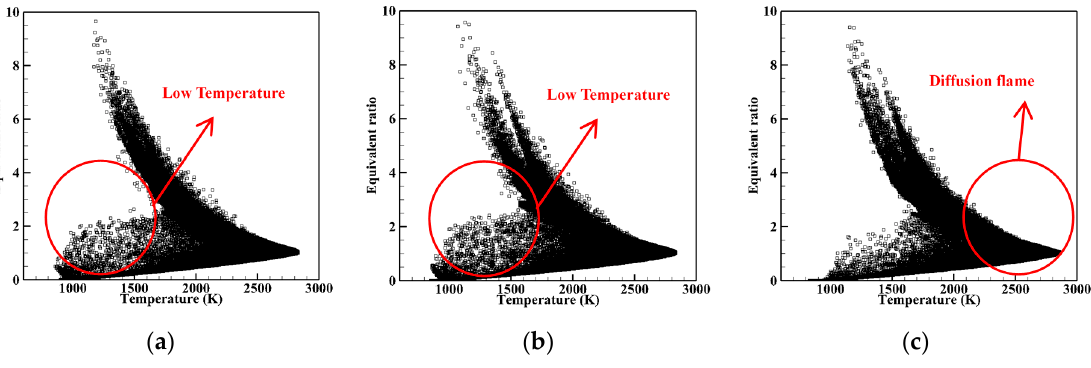
Figure 16. Map of equivalence ratio vs. temperature under different swirl ratios. ( a ) Swirl = 2; ( b ) Swirl = 4; ( c ) Swirl = 6.